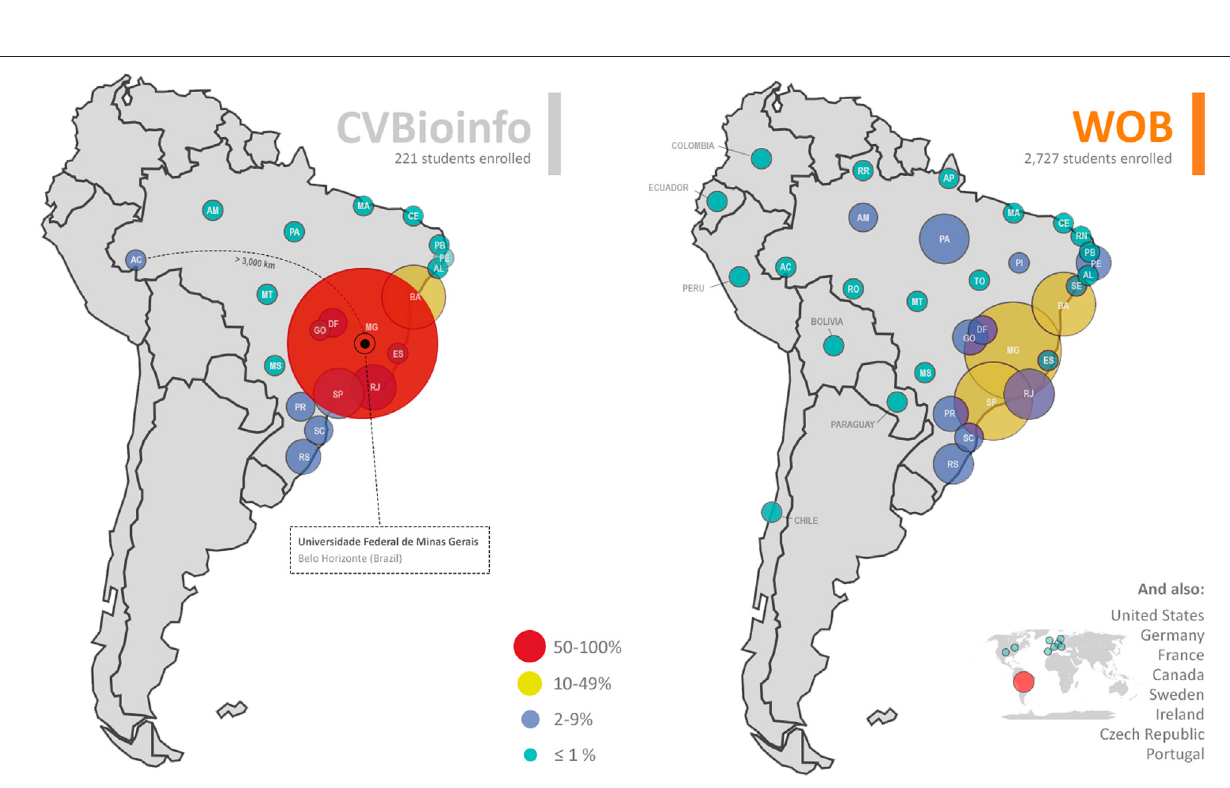
Frontiers in Bioinformatics |